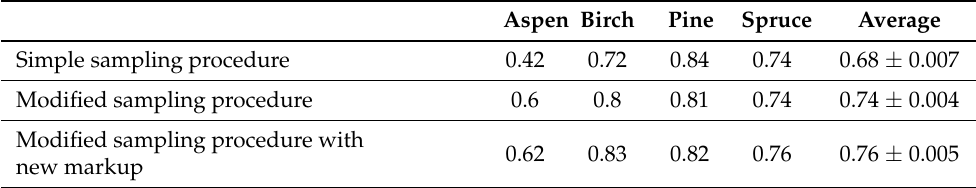
Table 6. Final aggregated results for forest types classification using modified sampling procedure and markup adjustment